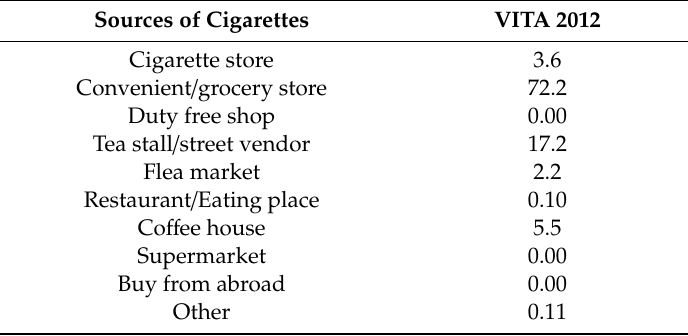
Table 3. Sources of cigarettes in the last purchase (%).